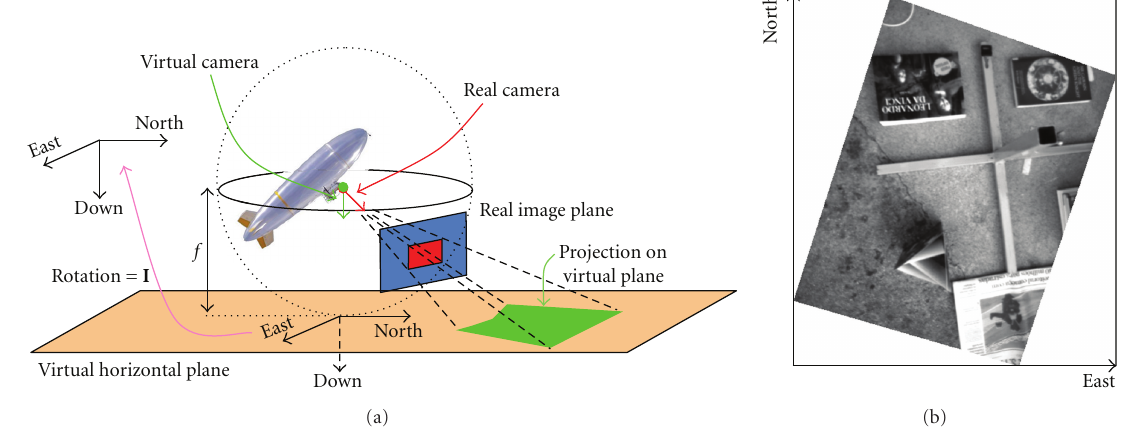
Figure 3: The virtual horizontal plane concept and an reprojected image